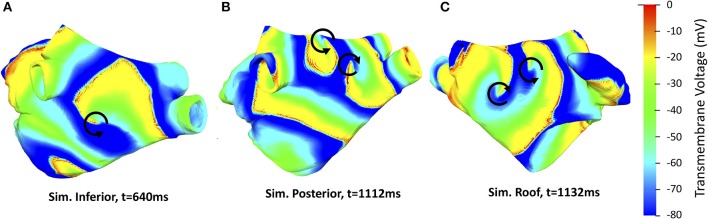
Representative screenshots of the three AF simulations considered with reentries indicated by black arrows. Color encodes the transmembrane voltage Vm. A counter-clockwise rotor is located on the low posterior wall in Simulation Inferior (A), a figure of eight pattern is present on the roof of Simulation Posterior (B) and a counter-clockwise reentry on the high anterior wall and a clockwise reentry below the right superior PV is present in Simulation Roof (C).